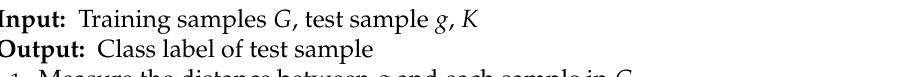
Algorithm 1 Main steps in the kNN